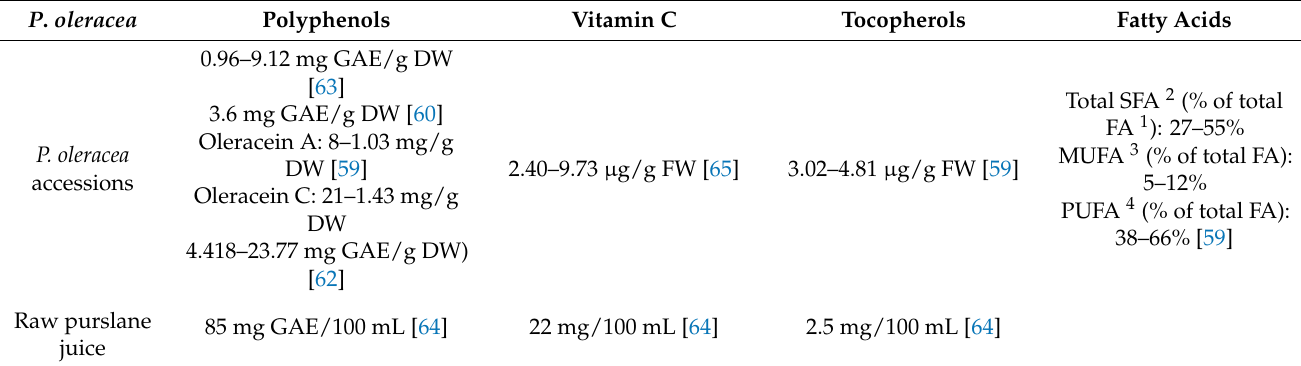
Table 4. Some examples of polyphenol, vitamin C, tocopherol, and fatty acid content in purslane. P .